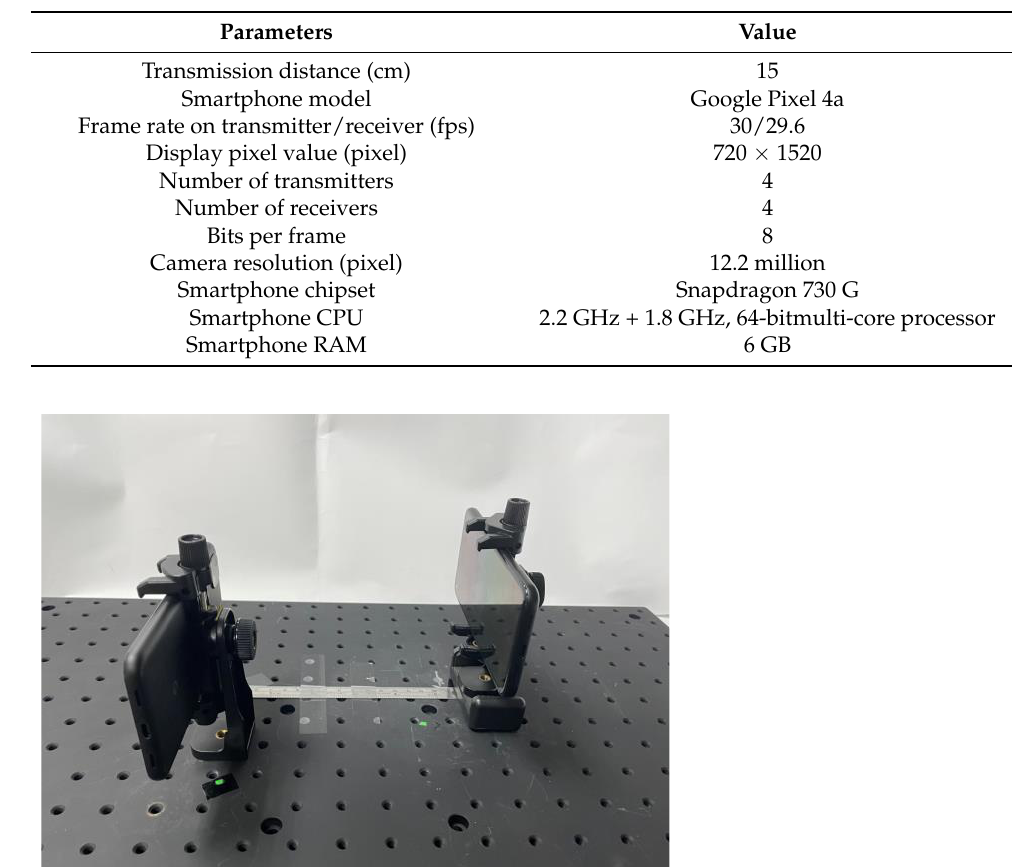
Table 1. Configurations of the VLC system.